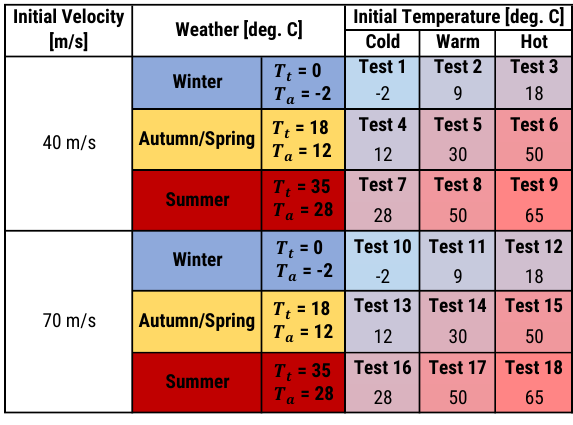
Figure 20. Test conditions.